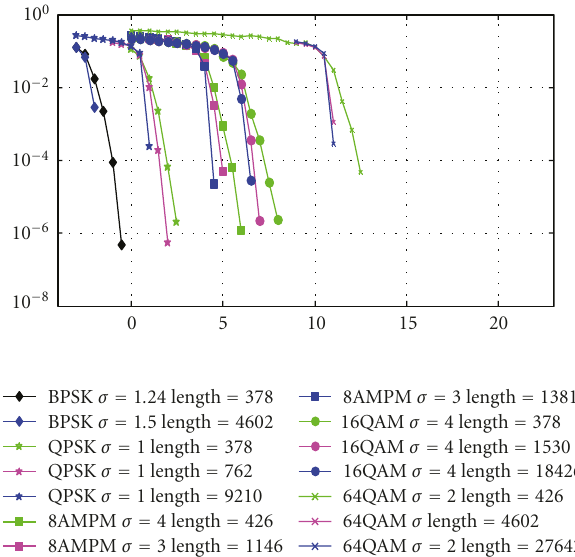
Figure 5: BER of nonadaptive turbo coded OFDM system.